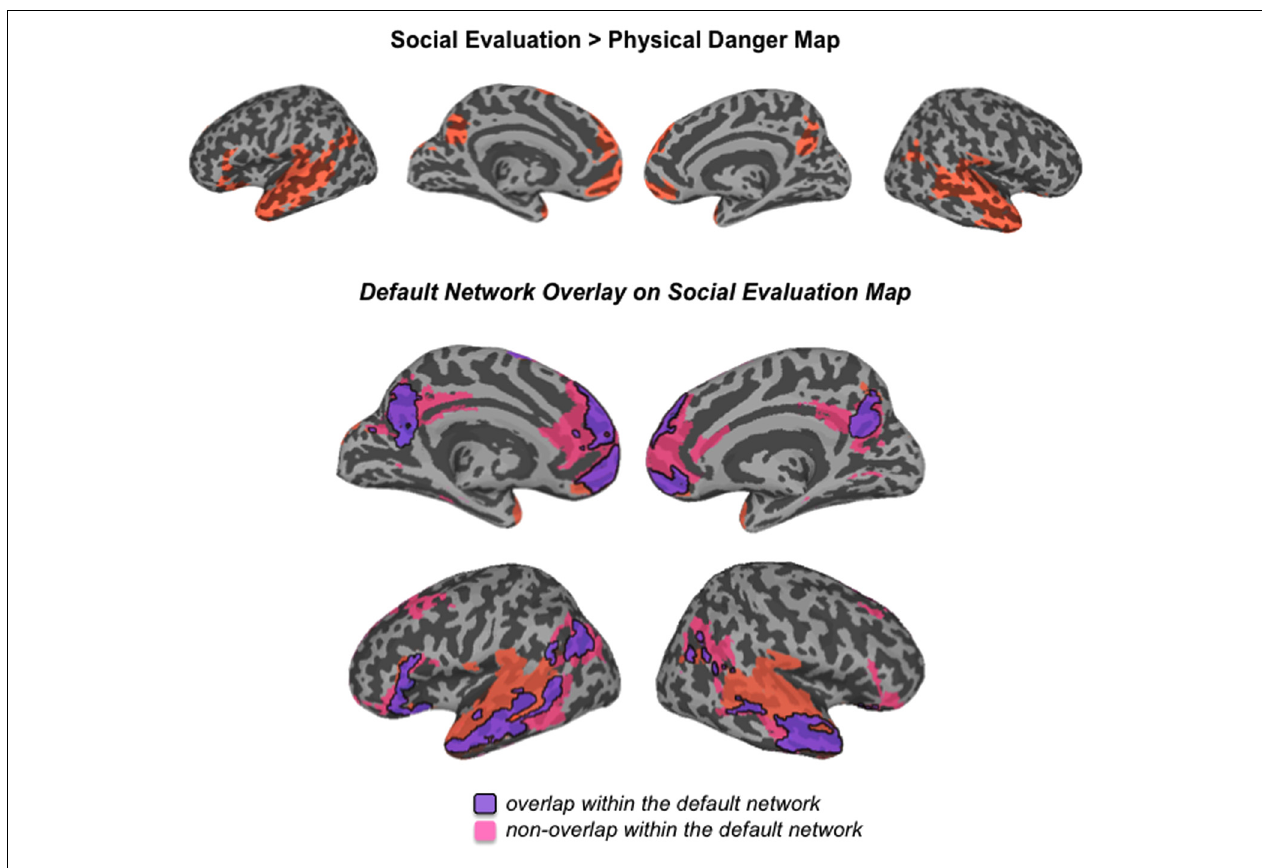
FIGURE 4 | Comparison of the social evaluation map from this study with the default mode network defined byYeo etal.